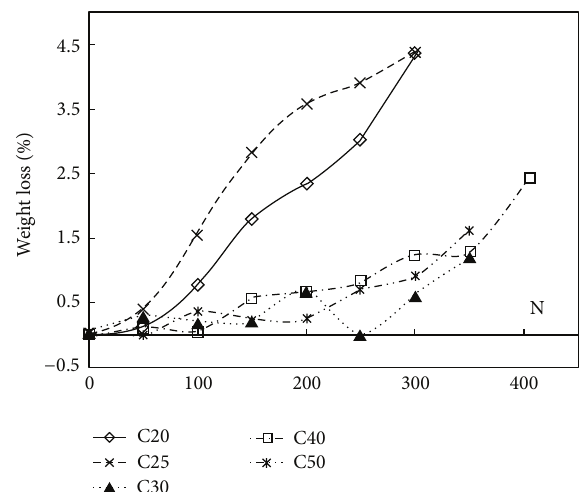
Figure 3: Effect of freeze-thaw cycles on weight loss of air-entrained